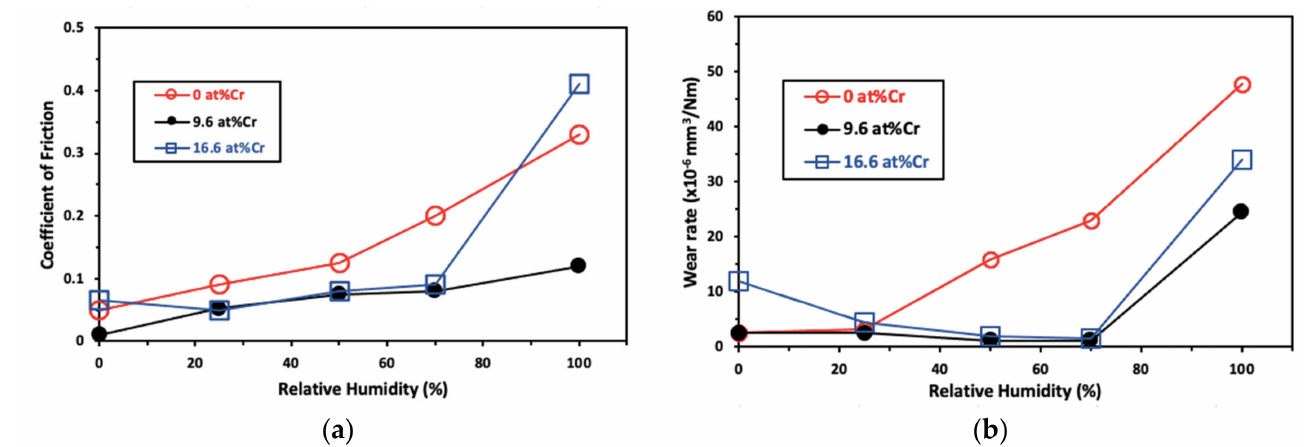
Figure 12. Friction coefficient and wear rate on sputter deposited MoS 2 /Cr composite film as a function of Cr content at different humidity levels: ( a ) variation friction coefficient with relative humidity and ( b ) variation of wear rate with relative humidity [122].